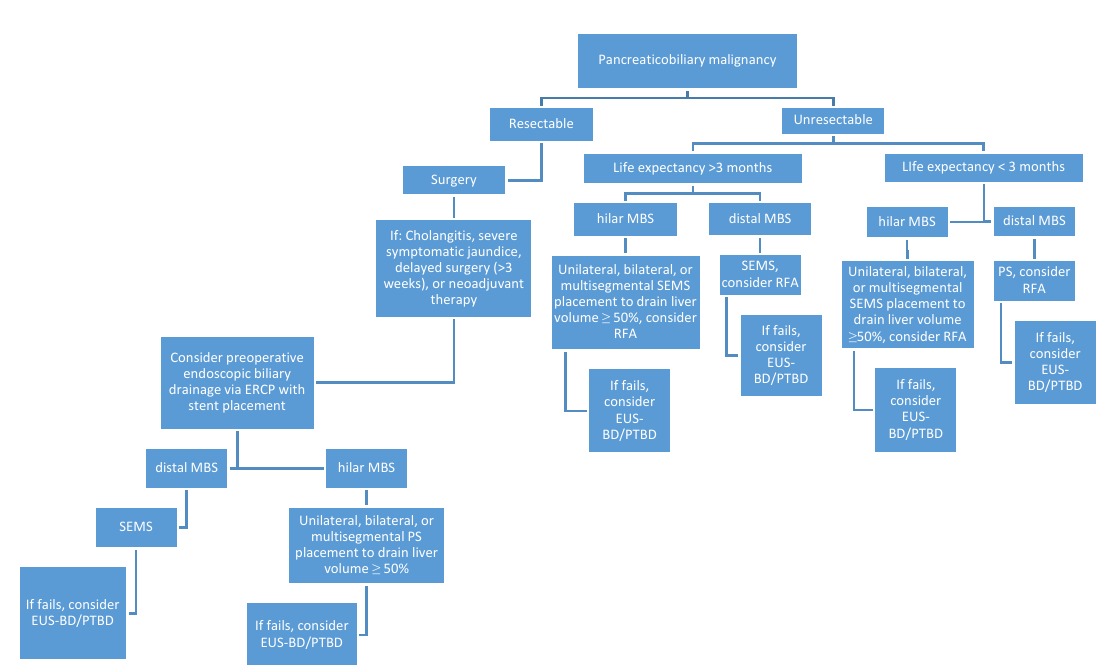
Figure 5. A flow chart summarizing the endoscopic approach to malignant biliary strictures.